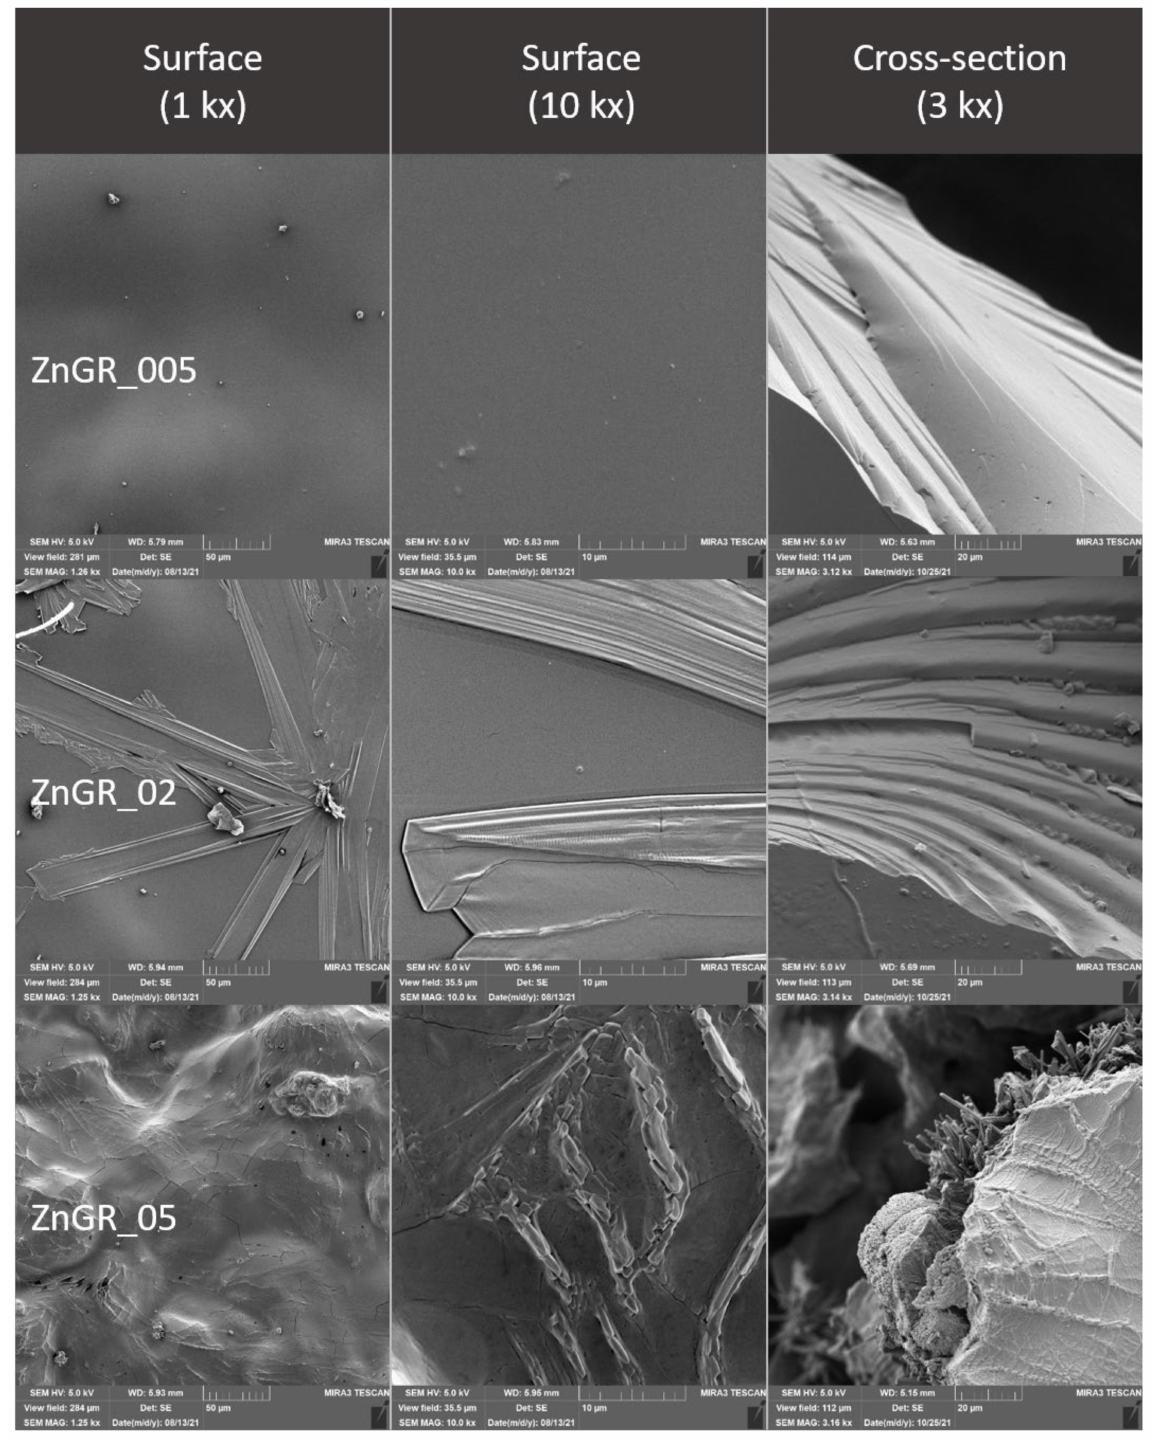
Figure 14. Surface and fracture microstructure of edible packaging with the addition of ZnO nanopar- ticles and grape